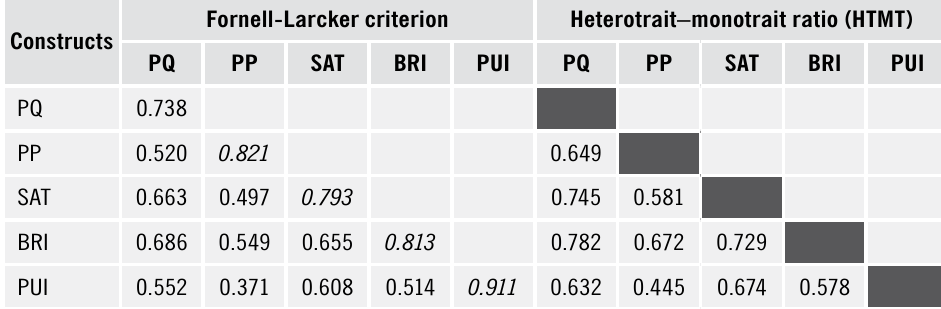
Table 4. Results of the discriminant